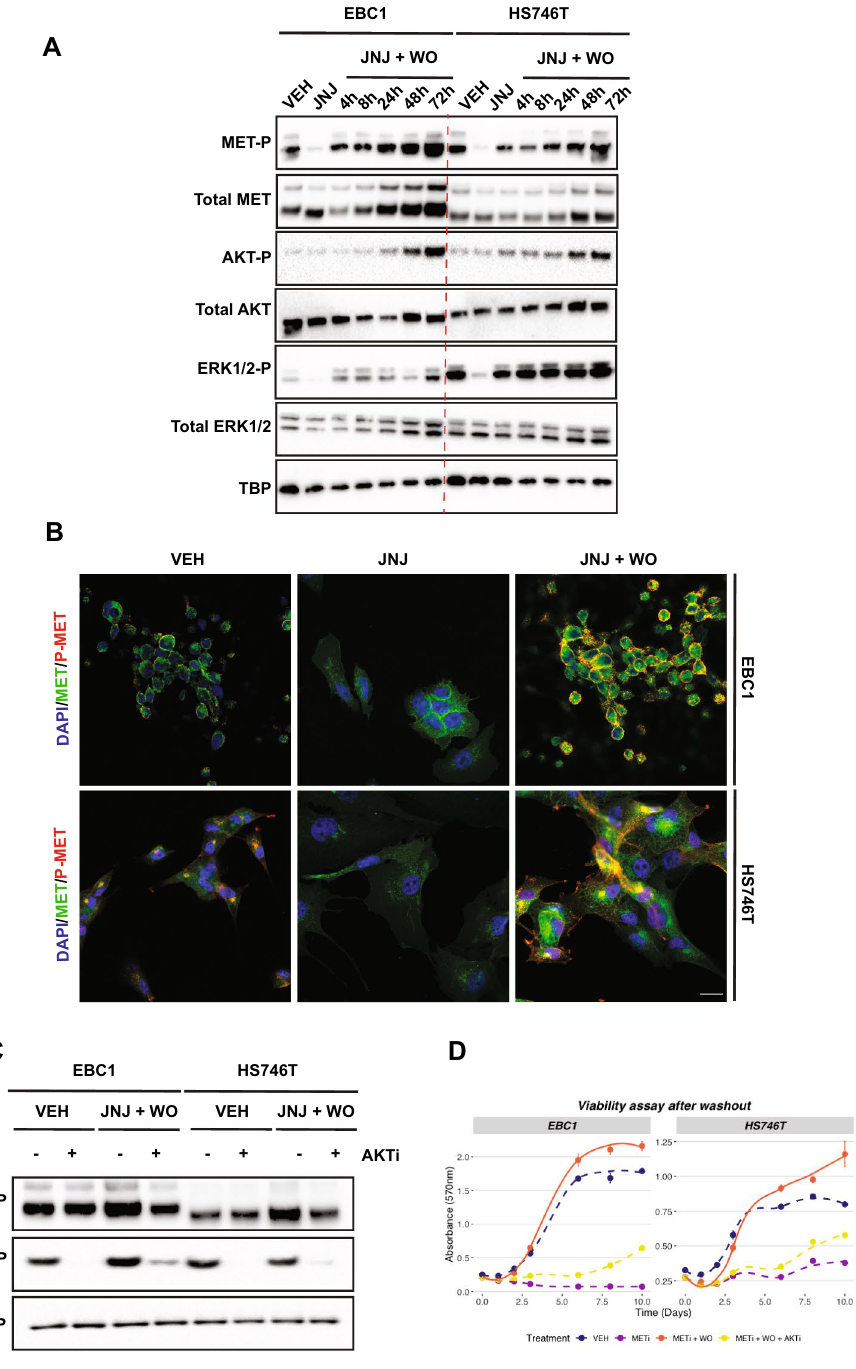
Figure 1. MET/AKT axis drives the ‘flare’ effect. ( A ) EBC1 and HS746T cell lines were treated ON with JNJ- 605 or DMSO (VEH). Following inhibitor withdrawal (WO), cells were harvested at the indicated time points (h). Total cellular lysates from the samples shown on top were immunoblotted, as indicated on the left. Black- edged rectangles delineate the blot. The dashed red vertical line highlights the separation between cell lines for clarity. ( B ) Confocal sections of EBC1 and HS746T cells untreated or subjected to JNJ-605 inhibition +/− WO. Cells were then fixed 48 h later and processed for immunofluorescence by staining with anti-phosphorylated MET (P-MET, 647 nm-red pseudocolour) or total MET (MET, 555 nm-green pseudocolour) antibodies and DAPI (blue pseudocolour). ( C ) EBC1 and HS746T cells were treated with DMSO (VEH) or JNJ. After WO, cells were treated with −/+ MK-2206 (AKTi) for 48 h. Black-edged rectangles delineate the blot. ( D ) Viability assay of EBC1 and HS746T cells subjected to indicated treatments. Results are mean +/− SEM with N =